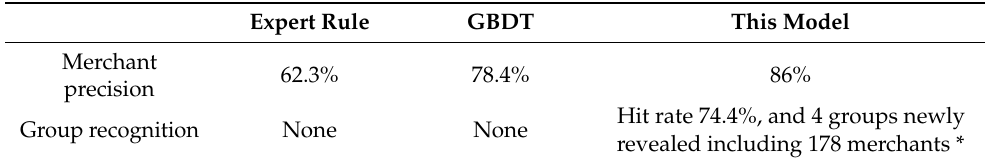
Table 7. Comparison of model